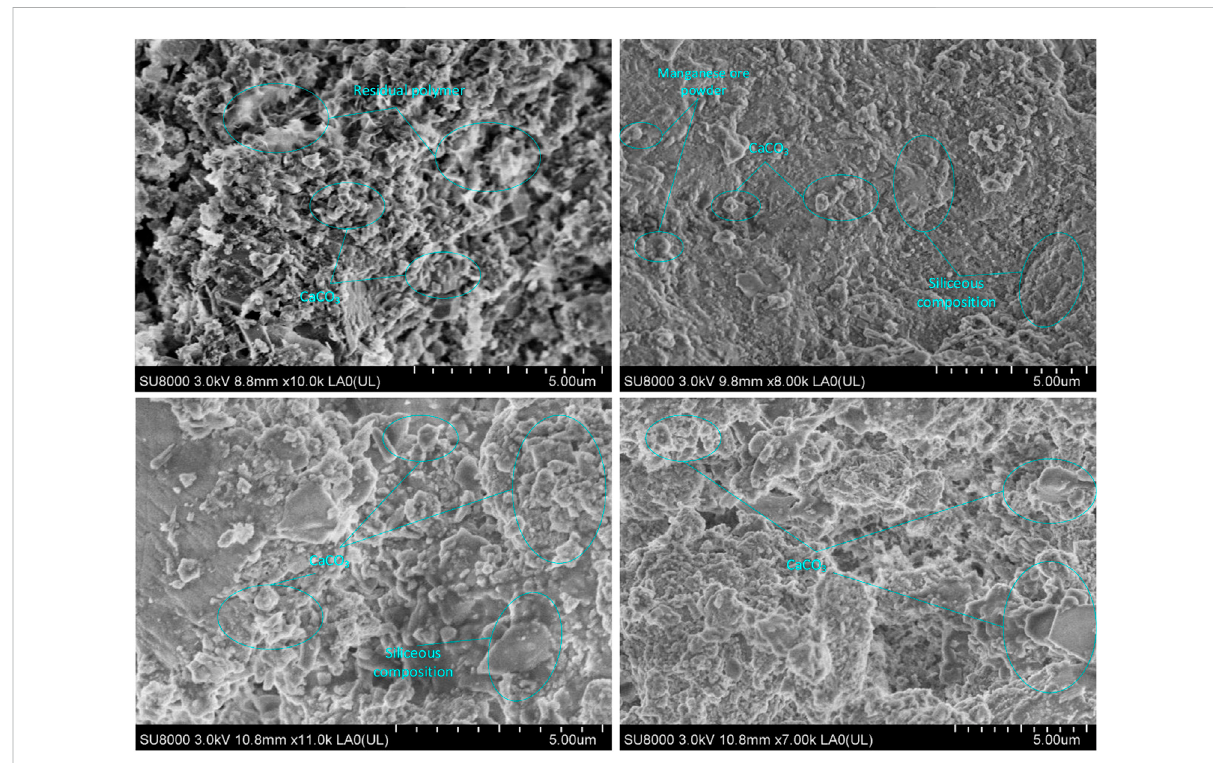
FIGURE 15 Microstructure of corrosion zone of BFs-HA-composite emulsion base cement